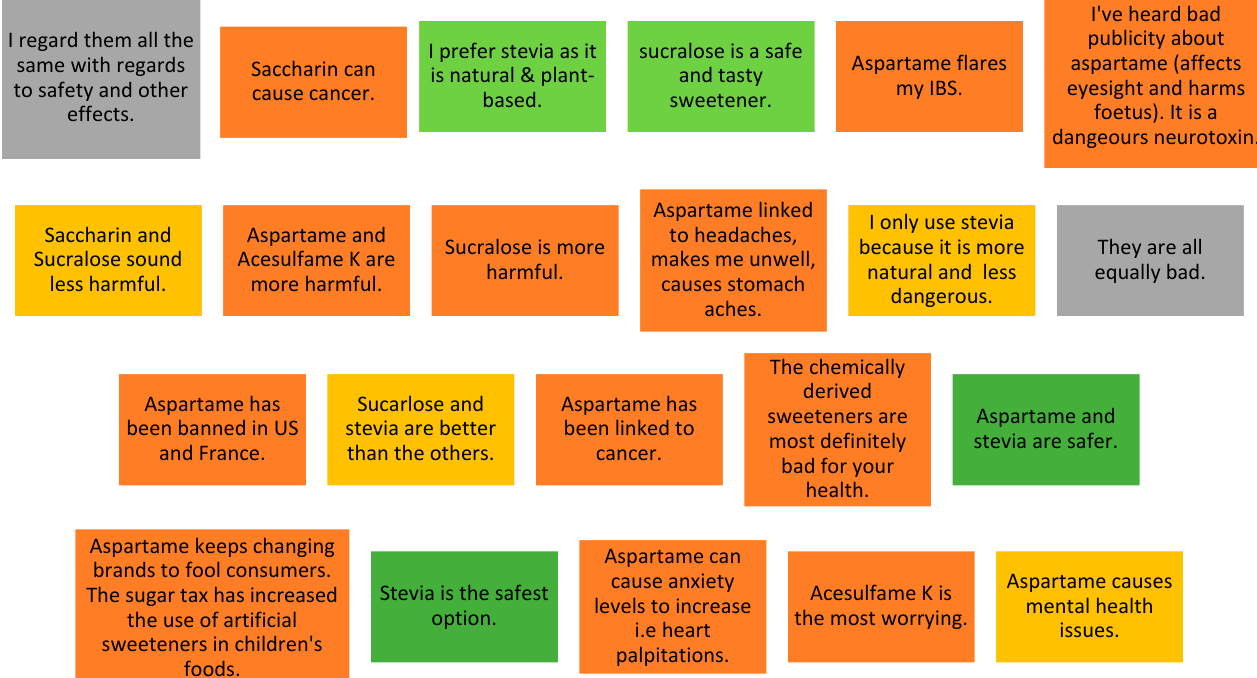
Figure 4. Perceptions towards different types of NNS as reported by survey respondents.